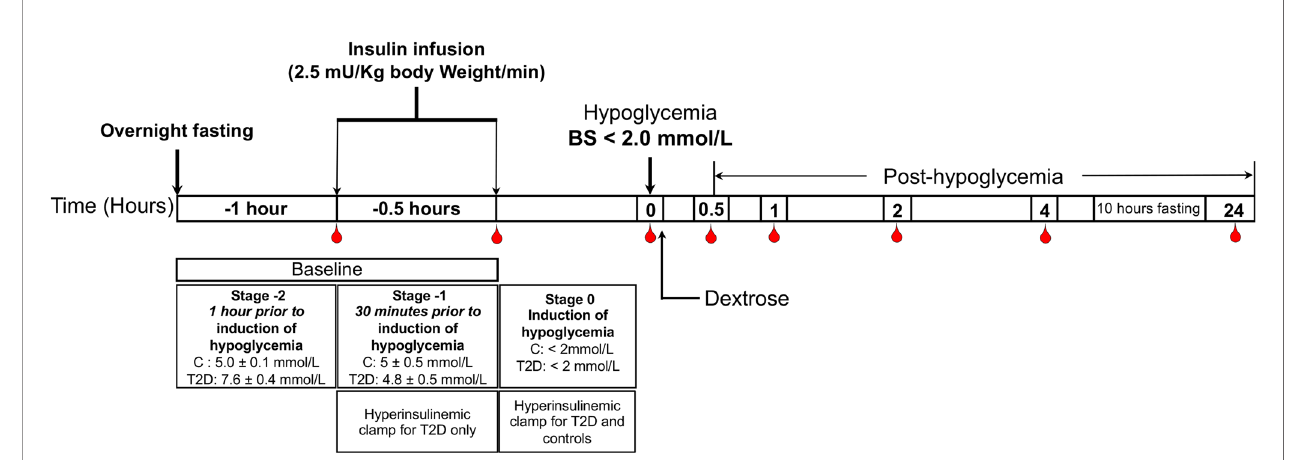
FIGURE 1 | Schematic diagram of the insulin clamp study, showing the intervention and blood sampling